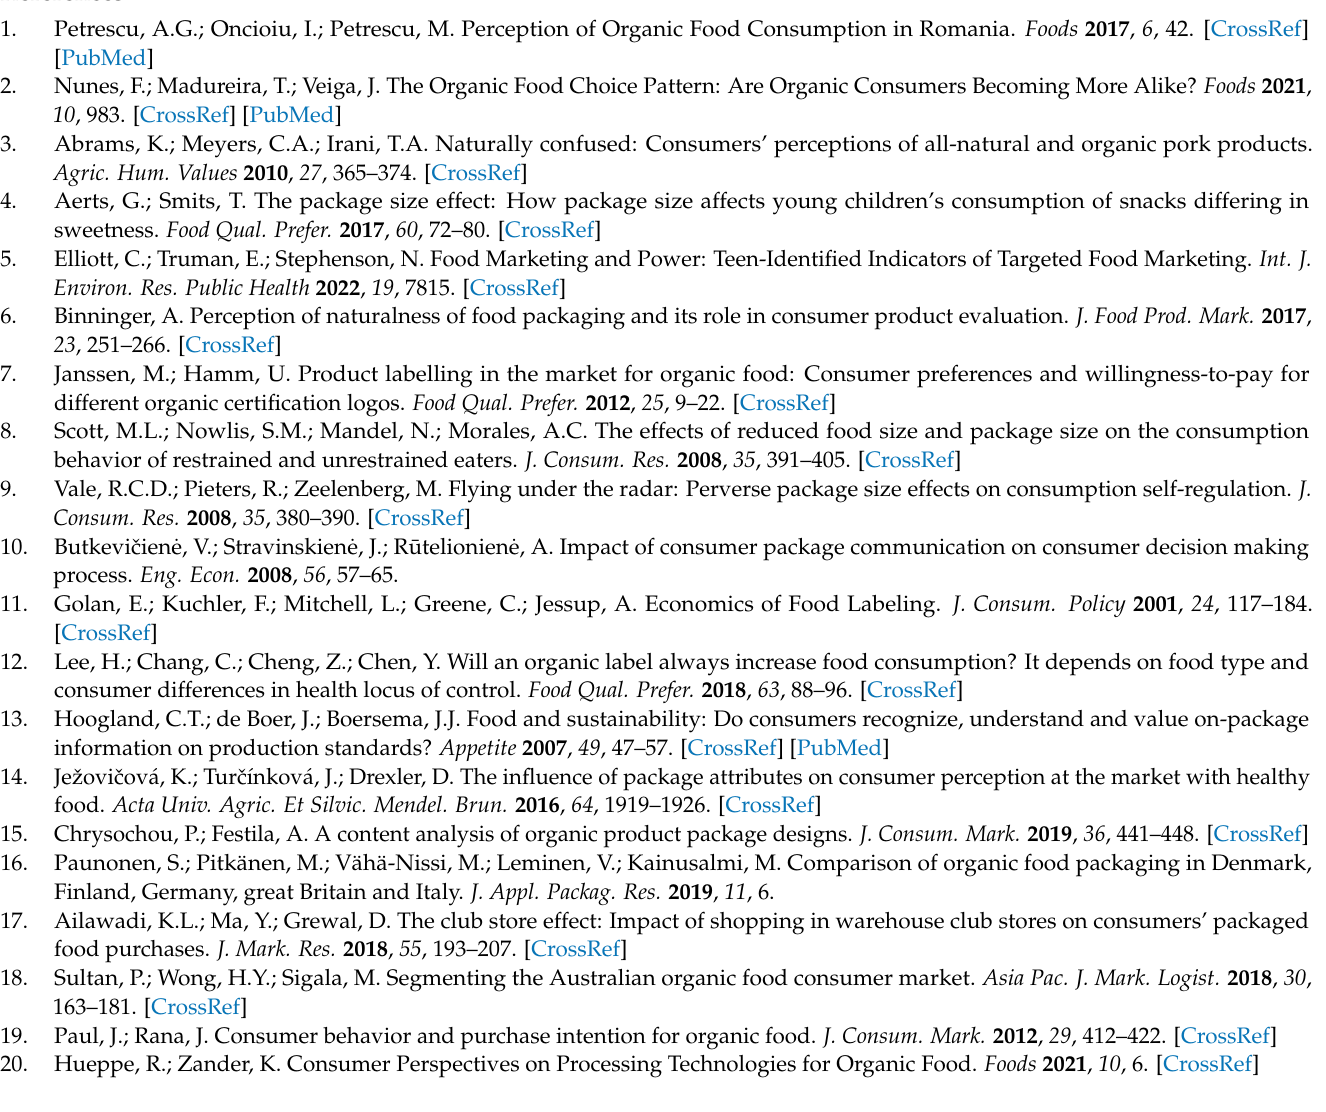
Figure A2. ( a ) Small package size, The Chinese meaning of the above figure is “Small package size ‘Green Life’ cabbage”. ( b ) Large package size, The Chinese meaning of the above figure is “Large package size ‘Green Life’ cabbage”.